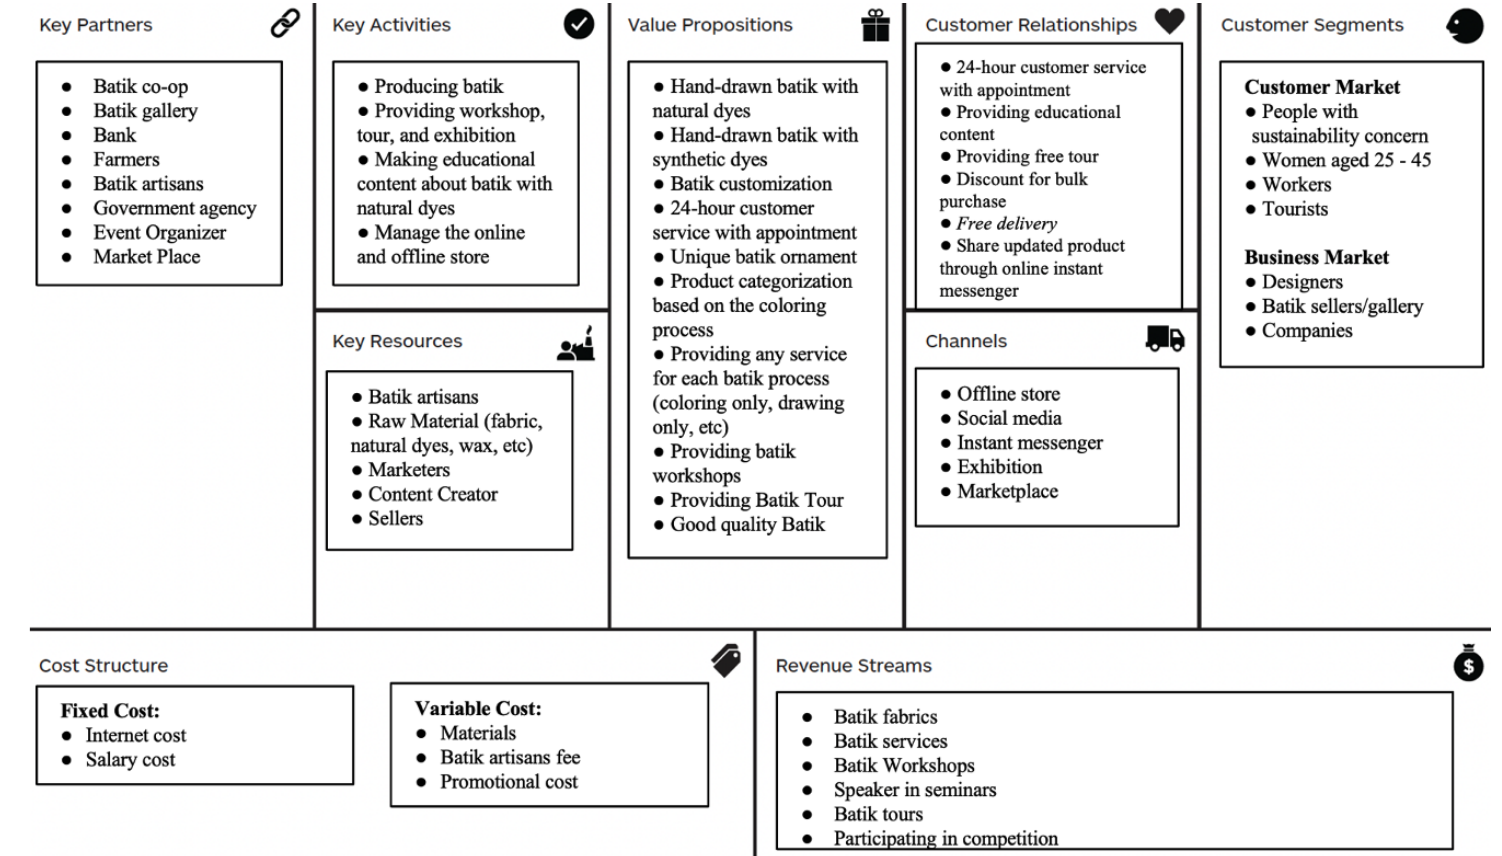
Figure 2: Proposed Sustainable Business Model; Source: Author (2022)